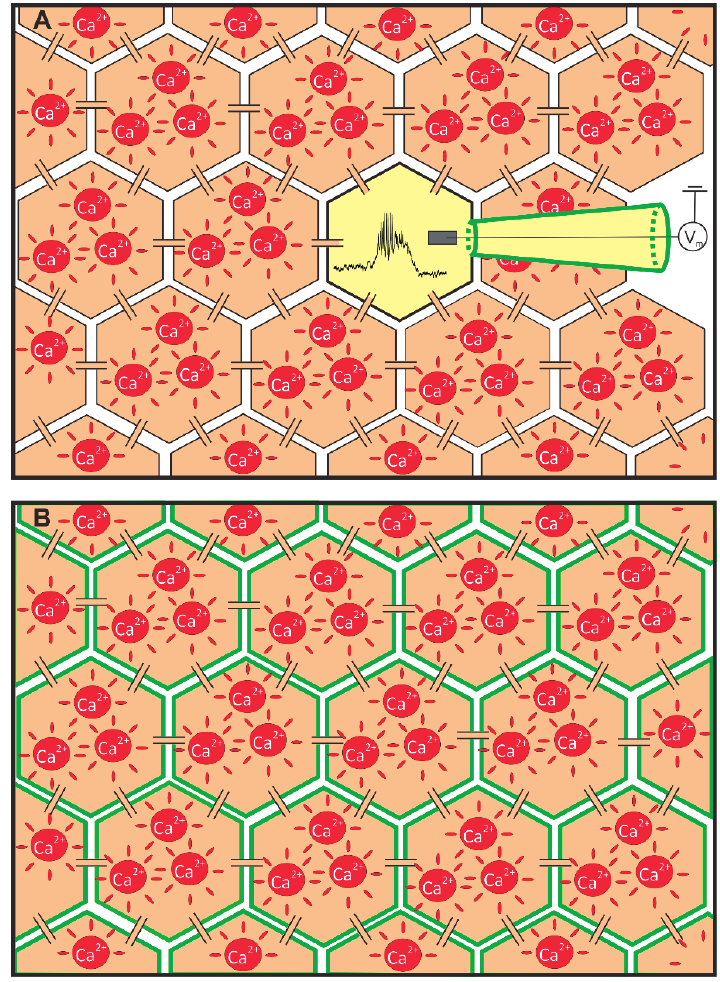
Figure 1. Experimental methods used to simultaneously measure MP and [Ca 2+ ] i . ( A ) A schematic representation of the whole-cell patch-clamp measurement of MP combined with recording [Ca 2+ ] i in the neighboring cells employing a CCD camera. MP from a single cell is monitored via a patch pipette (depicted with green lines), whereas the neighboring cells were loaded with Oregon Green BAPTA-1 AM to monitor changes in [Ca 2+ ] i ; and ( B ) a schematic representation of confocal MP measurement using the voltage sensitive dye Voltage Fluor 2.1 (VF) combined with [Ca 2+ ] i recordings using Rhod-2